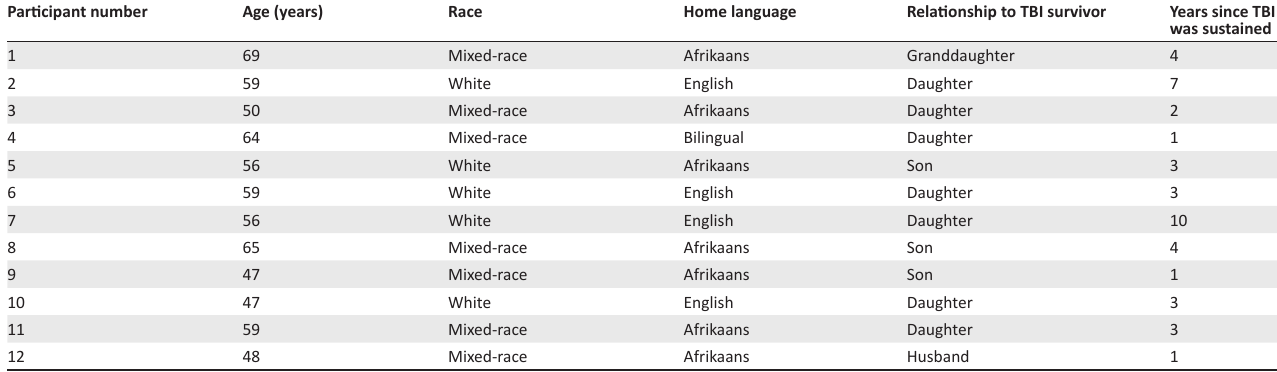
TABLE 1: Participant